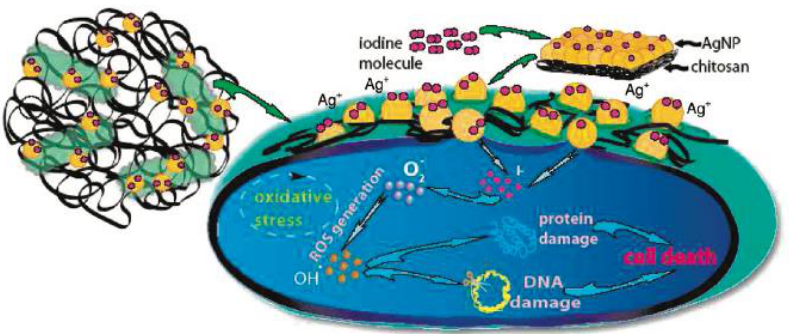
Figure 8. Schematic representation of the proposed mechanism of antibacterial activity of the iodinated CS-AgNPs composite. Reproduced with permission from reference [108]. Copyright 2010 ACS.